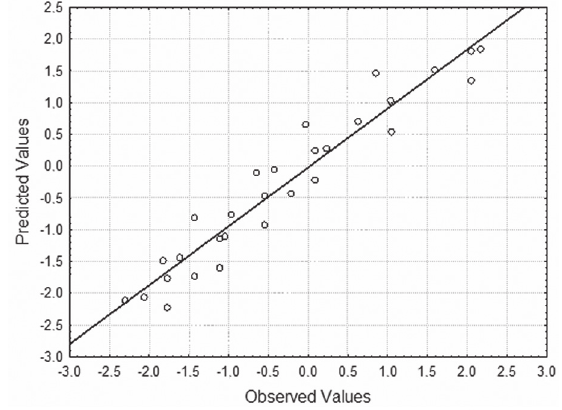
Figure 7 - Observed values versus predicted values of ln η as calculated by Equation